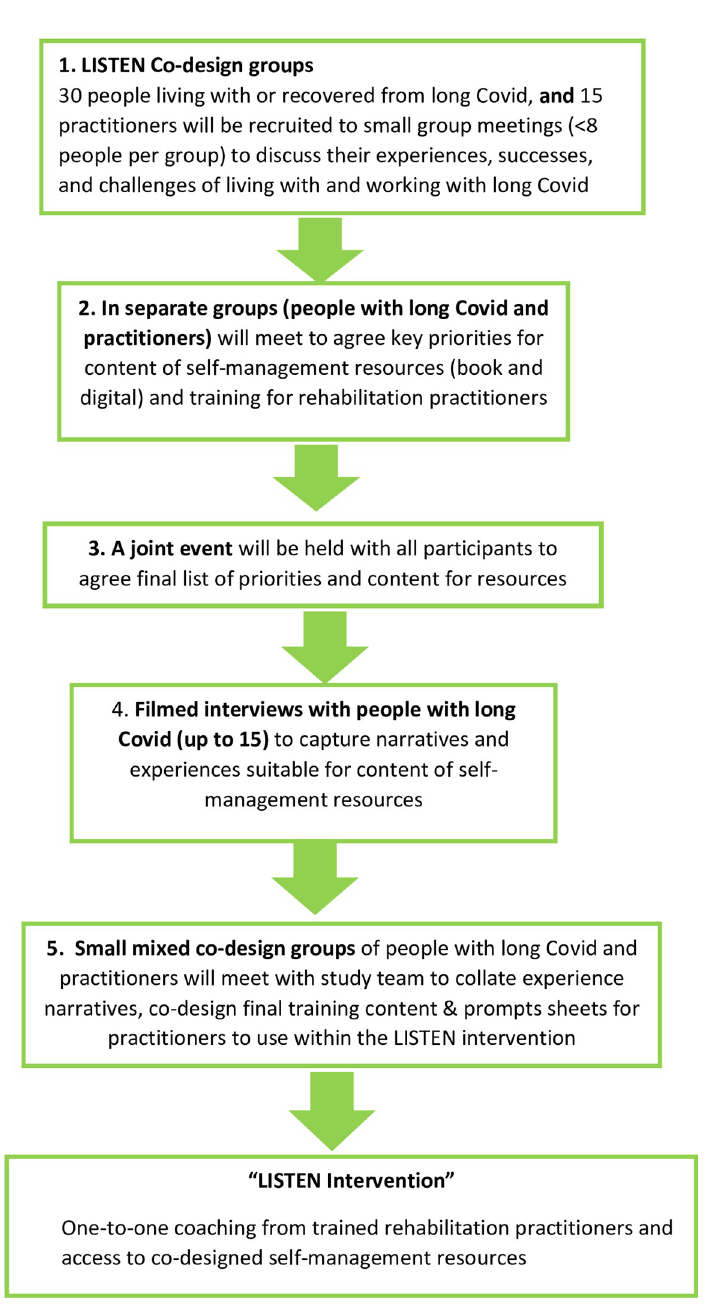
Fig 1. Study flow